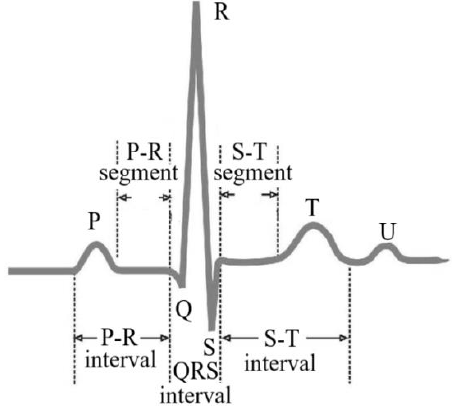
Figure 9. Typical ECG waveform.